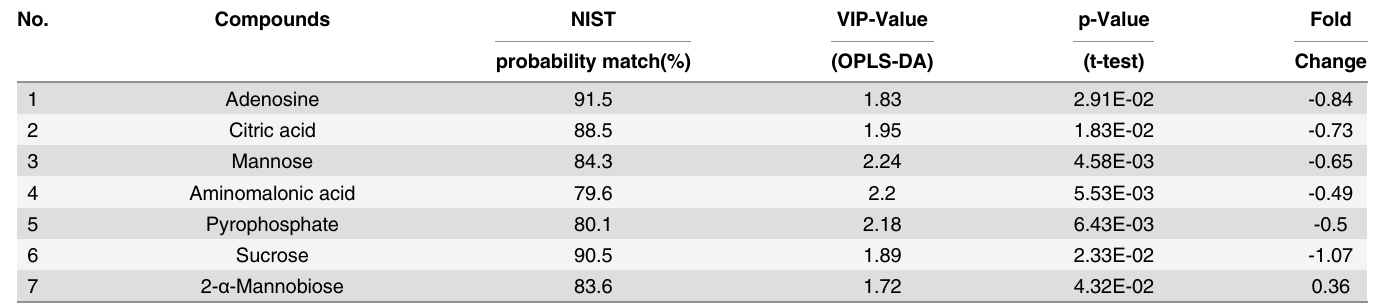
Table 3. The differential metabolites in liver between C3H-FB and C3H control mice.